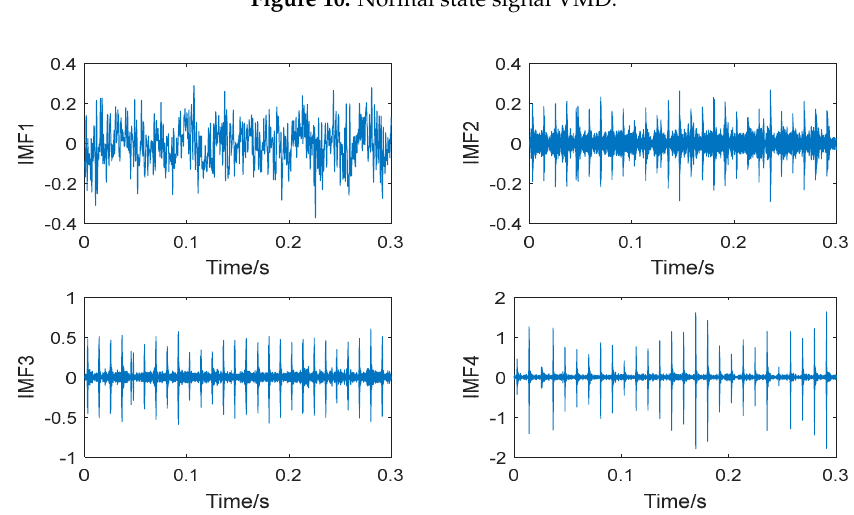
Figure 11. Outer ring defect state signal VMD.